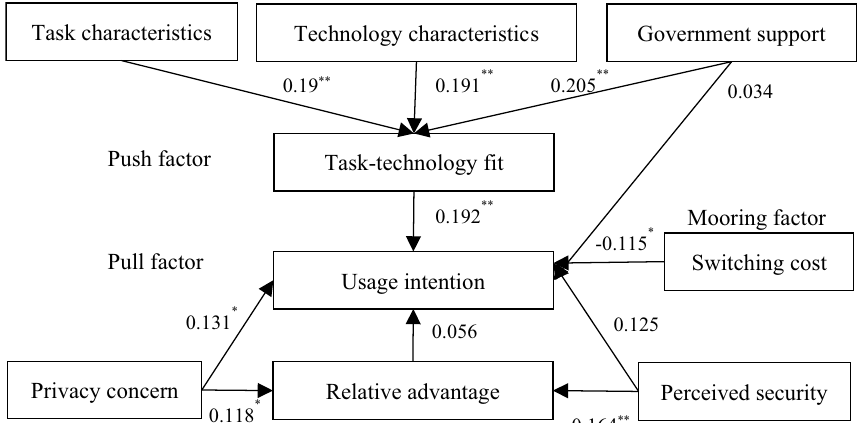
Fig. 3 Hypothesis testing effect of the integrated model